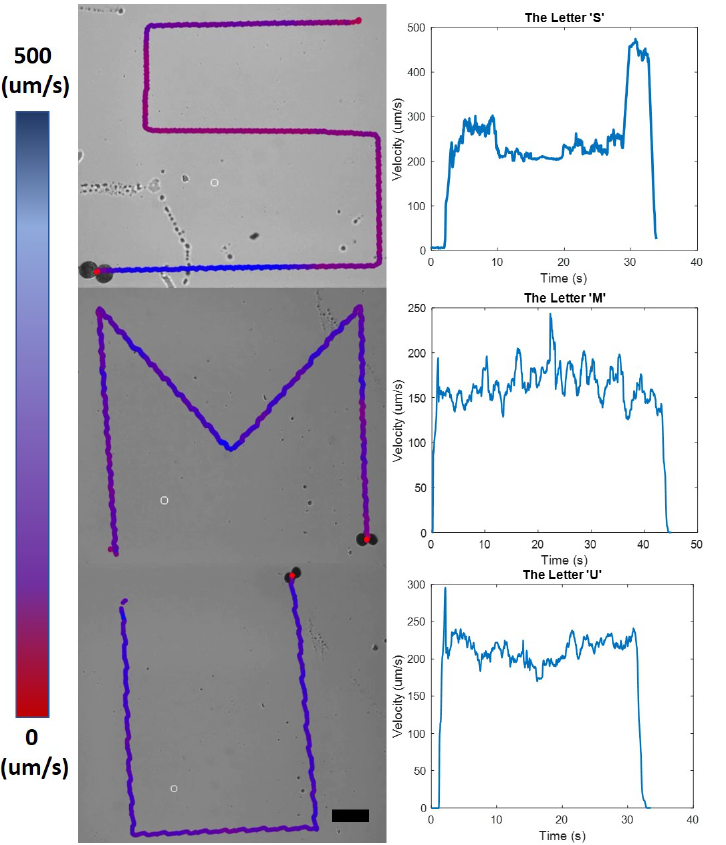
Figure 4. Trajectory of a microsnowman robot using open-loop control; the microrobot was rolled to follow the patterns ‘S’, ‘M’, and ‘U’. For each figure, the robot was located at the finish position. The gradient colorbar shows the velocity of the microsnwoman robot in each location. The scale bar is set to 400 micron. The travel time is 33, 45, and 33 s for the letters ‘S’, ‘M’ and, ‘U’,